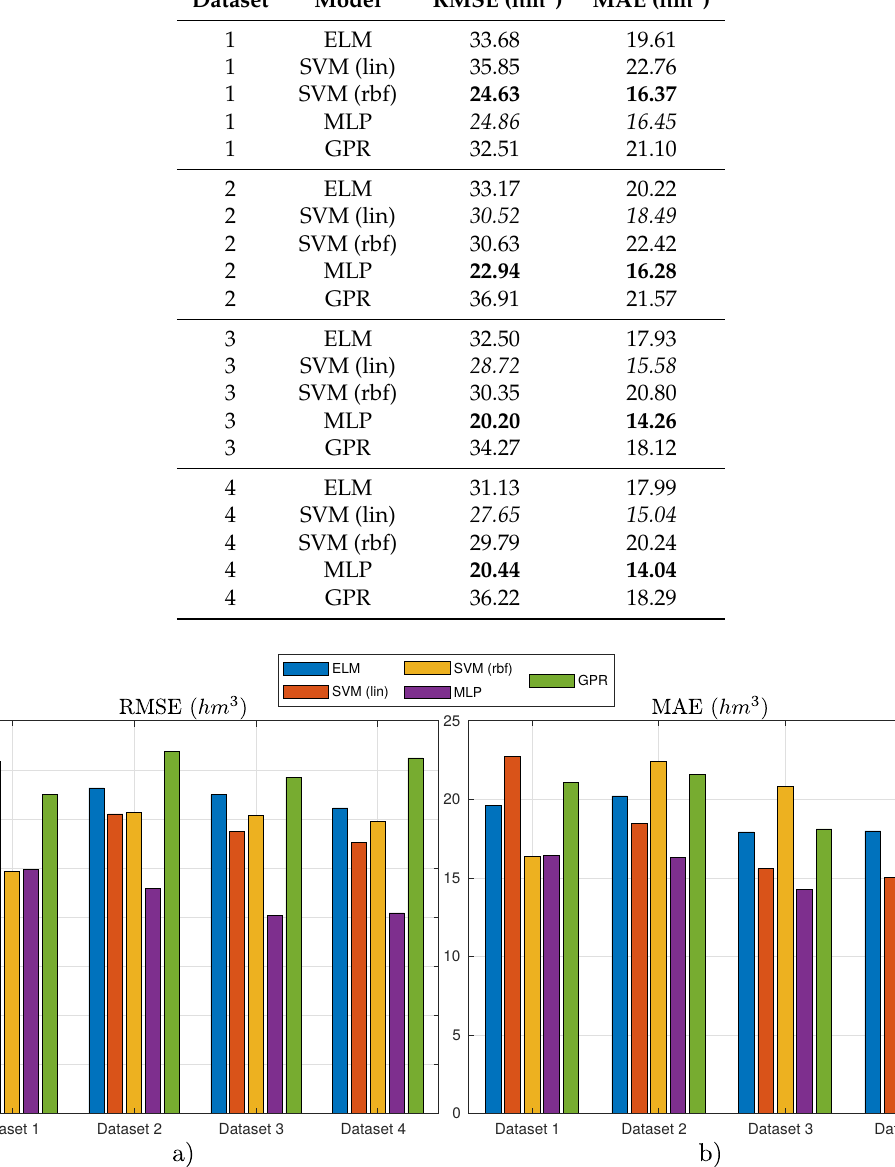
Figure 7. Results of the different ML regression techniques for different variables considered (datasets) in the case of standard data (all seasons) and random partitioning: ( a ) the RMSE results; and ( b ) the MAE